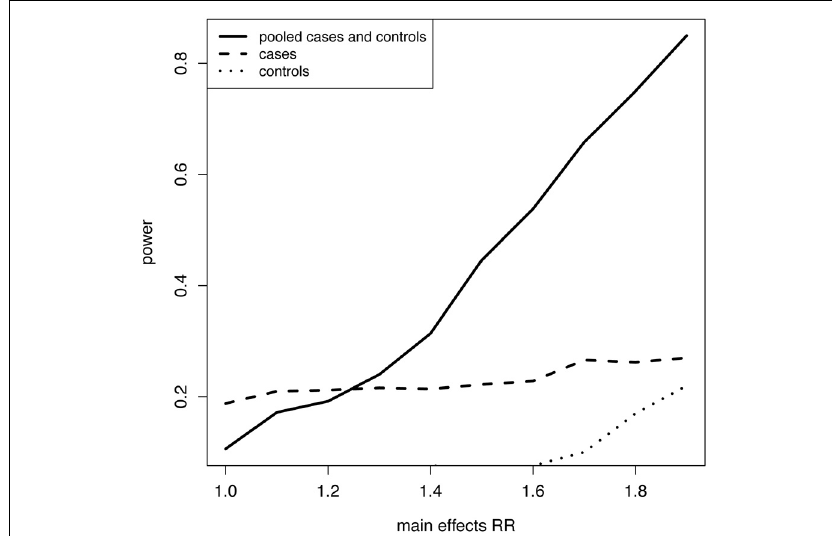
FIGURE 1 | Power in cases, controls, and a pooled case-control sample for a screening procedure based on LD between SNPs. Empirical power calculations were plotted for detection of composite LD between two SNPs, independent in the general population, coded additively in the number of minor alleles, with minor allele frequencies of 0.2. Detection of composite LD was performed by applying the t-distribution to Pearson’s product moment correlation coefficient with α = 0 . 05. A population of 40000 individuals including a binary disease trait was simulated according to the model, log ( P [ D ] ) = λ + β 1 ∗ SNP1 + β 2 ∗ SNP2 + β 3 ∗ SNP1 ∗ SNP2, where baseline risk of disease was 5%, main effects were equal, β 1 = β 2 , and the interaction was weak exp( β 3 ) = 1 . 1. Power of the screening procedure as described above is plotted over a range of main effect relative risks [main effects RR = exp( β 1 ) = exp( β 2 )] for a sample of 1000 cases only, 1000 controls only, and a pooled case-control sample of 1000 cases and 1000 controls randomly sampled from the